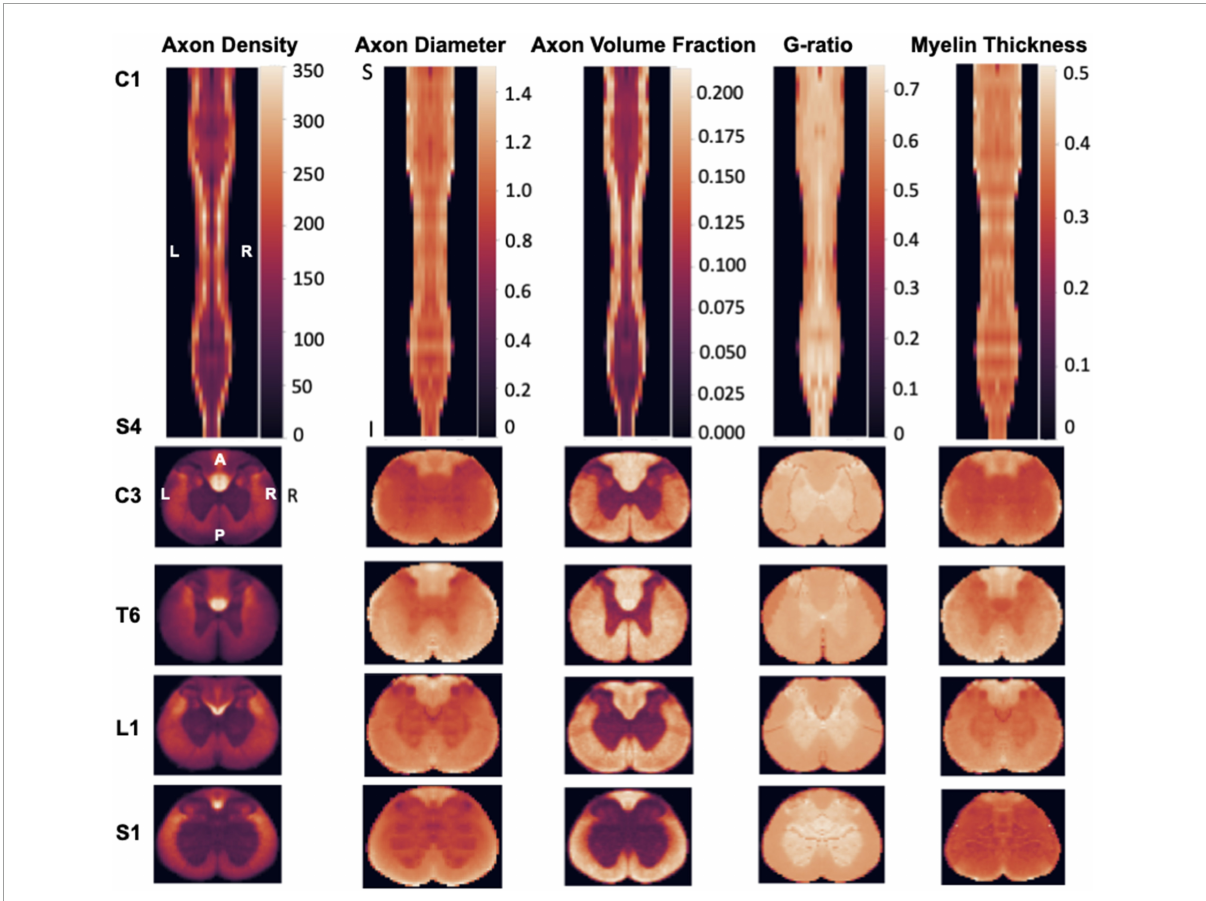
FIGURE2 Morphometric maps from the rat spinal cord template ( N = 5 rats). (Top Row) Coronal view metric map covering the entire spinal cord (from C1 to S4). (Bottom Rows) Selected axial views from each section of the spinal cord (Cervical, Thoracic, Lumbar, Sacral). Note that the scale of each axial view was adjusted to fit the rectangle panel, so the relative size of the spinal cord across levels cannot be compared across axial